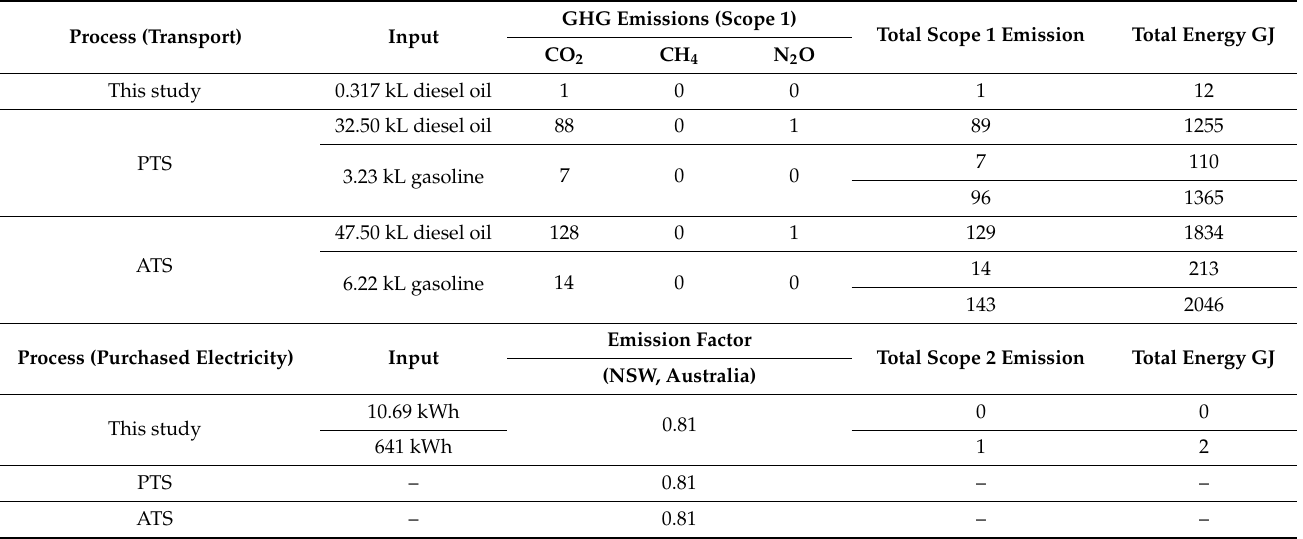
Table 3. Direct and indirect greenhouse gas emissions based on Australia’s National Greenhouse Energy Reporting